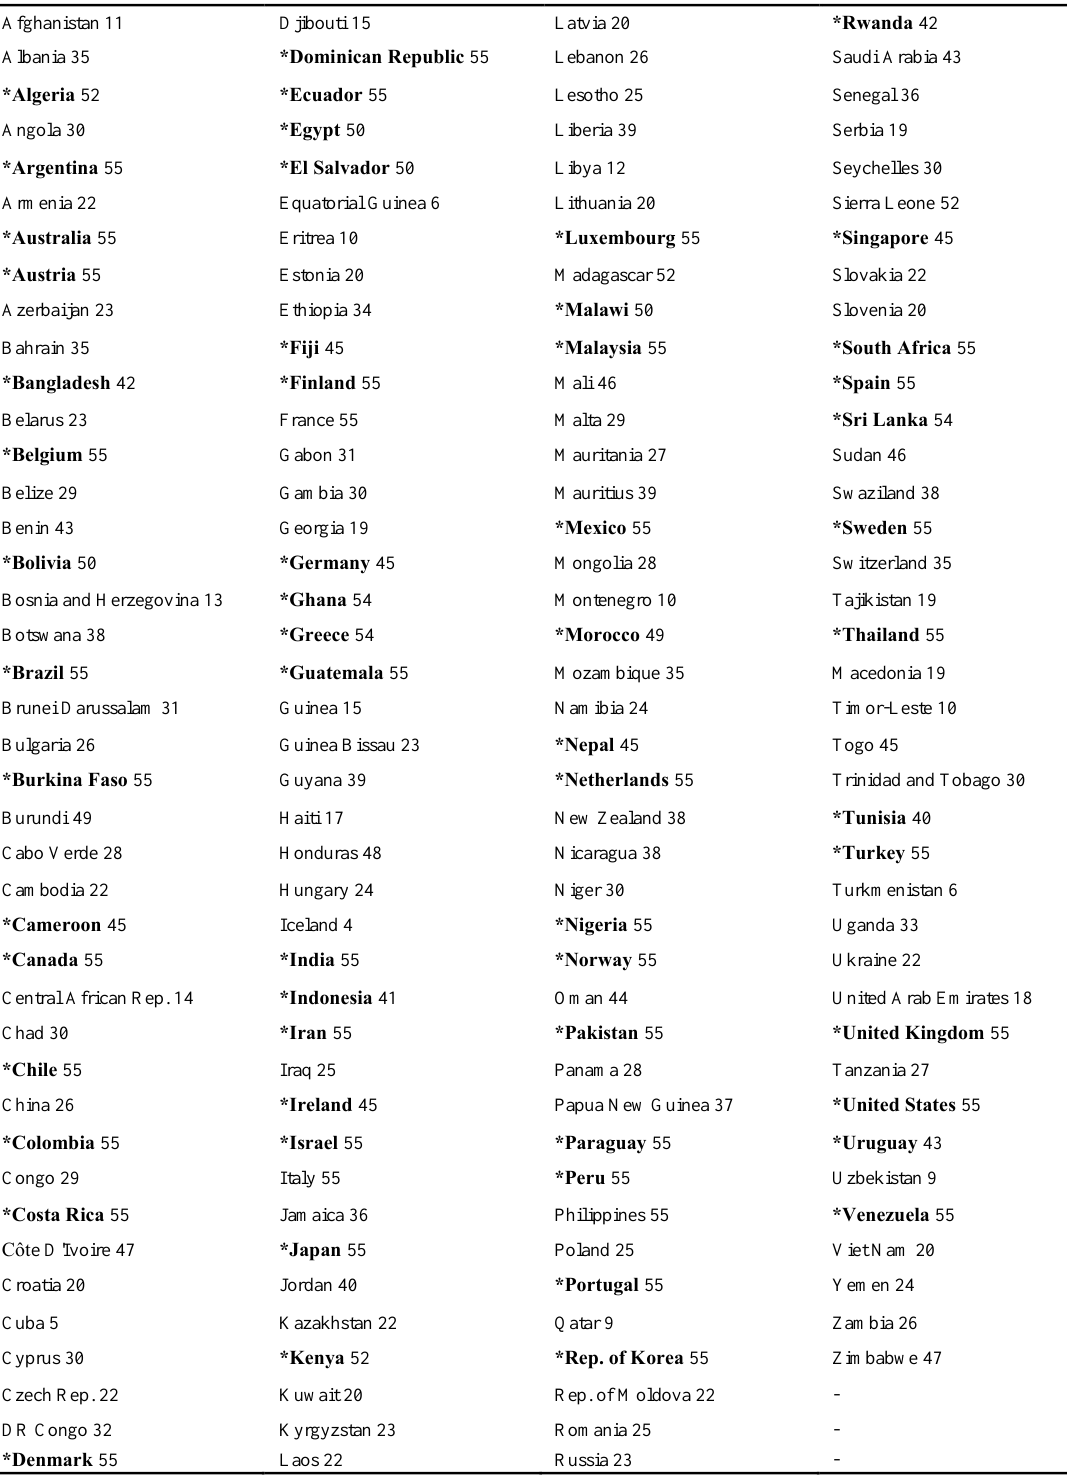
Countries included in balanced panels are flagged by asterisks. Balanced panels include 40 obs. per